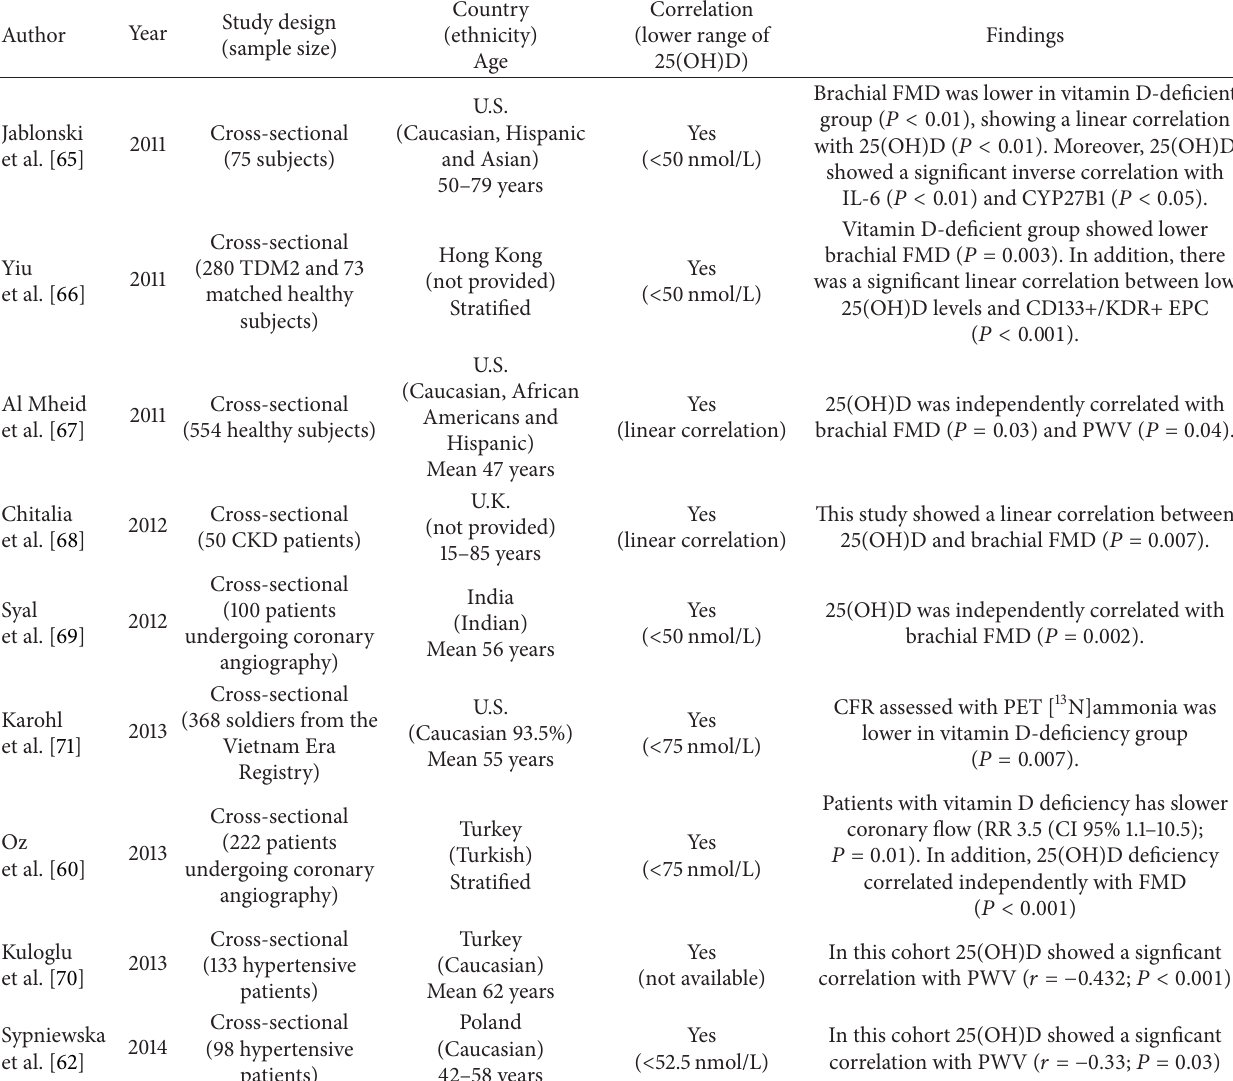
Table 3: Observational studies investigating the relationship between vitamin D and endothelial